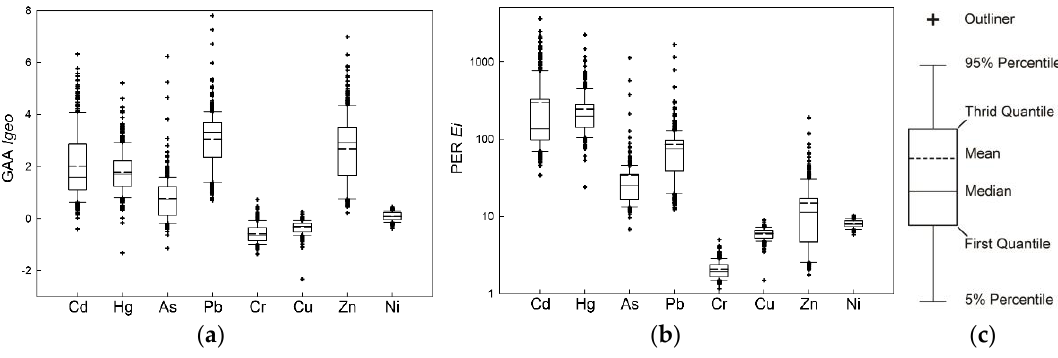
Figure 2. Boxplots of GAA ( Igeo ) ( a ) and PER ( E i ) ( b ), and the Legend ( c ) for metals in cropland soils of Zhehai. Notes: GAA: geoaccumulation assessment, PER: potential ecological